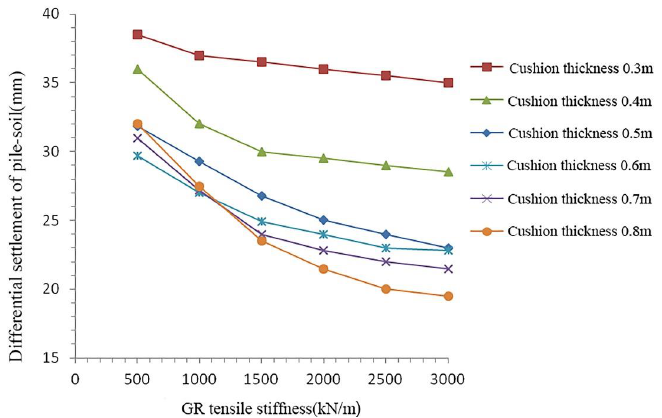
Figure 14. Differential settlement of pile soil with different GR tensile stiffness and cushion thick- ness values.